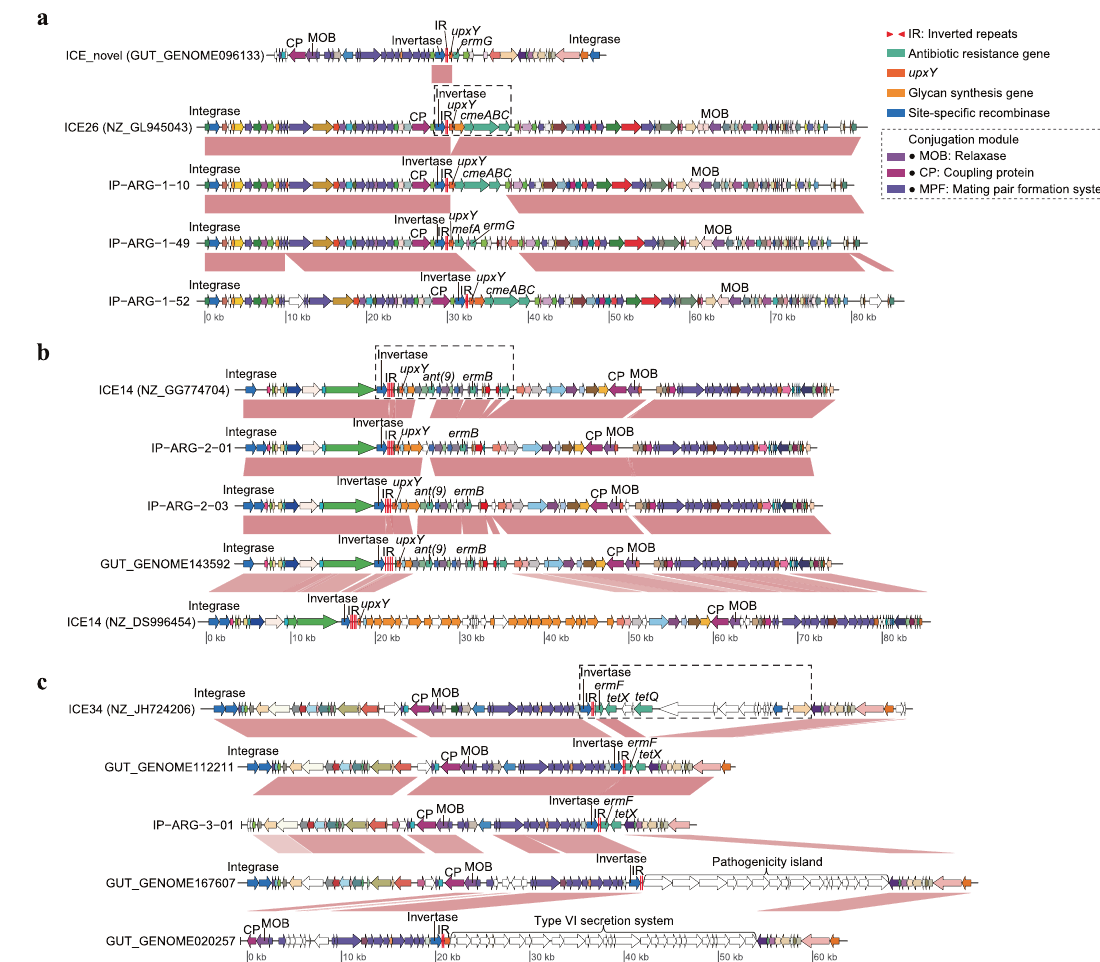
Fig. 2 Genomic comparison and context analysis of representative contigs carrying IP-ARG-1 (a), IP-ARG-2 (b), and IP-ARG-3 (c) as well as related elements. The regions located adjacent to the invertible promoters (black-dotted boxes) were found to be highly variable across element variants within each ICE. ICE26, ICE14, and ICE34 are ICE accession numbers from ImmeDB. ICE_novel1 is a newly identi fi ed ICE that has not been included in the ImmeDB database. The NCBI genome-accession numbers are shown in the parentheses after the ICE accession numbers. The sequence labels that start with GUT_GENOME are genome-accession numbers of the UHGG database. Orthologous genes are plotted with the same color and are linked by pink connections. Site-speci fi c recombinase, antibiotic resistance, and glycan-synthesis genes are colored blue, light green, and orange, respectively. The genes that do not have orthologs are